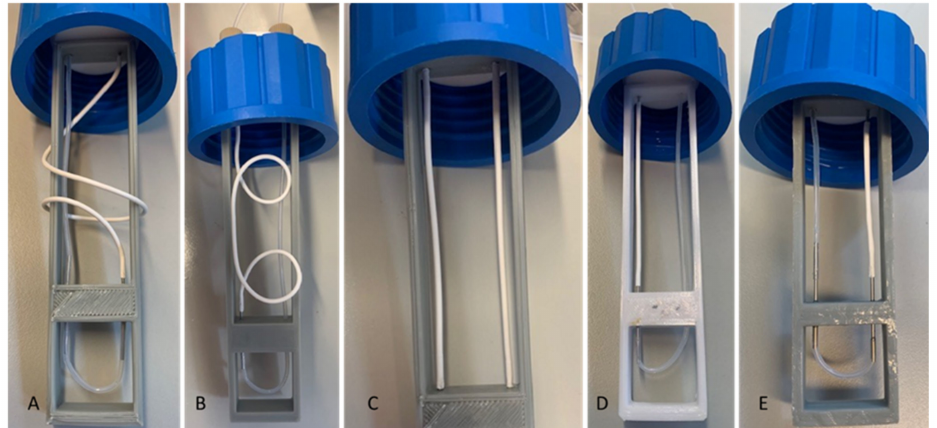
Figure 9. Pictures of the 5 microporous tube configurations of different tube lengths and positions. ( A ): L = 20 cm, coiled; ( B ): L = 14 cm, coiled; ( C ): L = 14 cm, straight; ( D ): L = 7 cm, straight; ( E ): L = 3.5 cm,